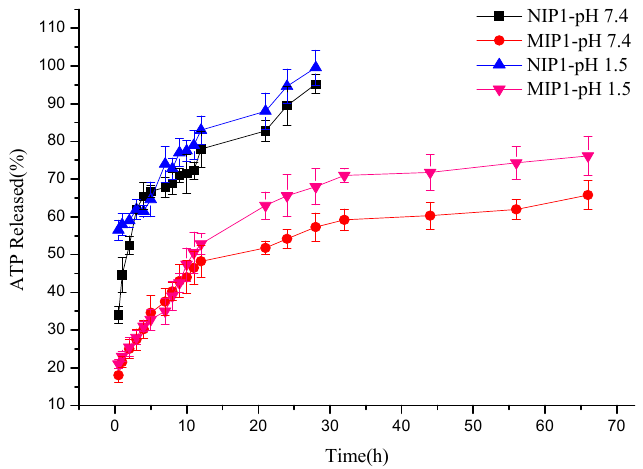
Figure 8. ATP released profiles in intestinal fluid (pH 7.4) and simulated gastric fluid (pH 1.5).